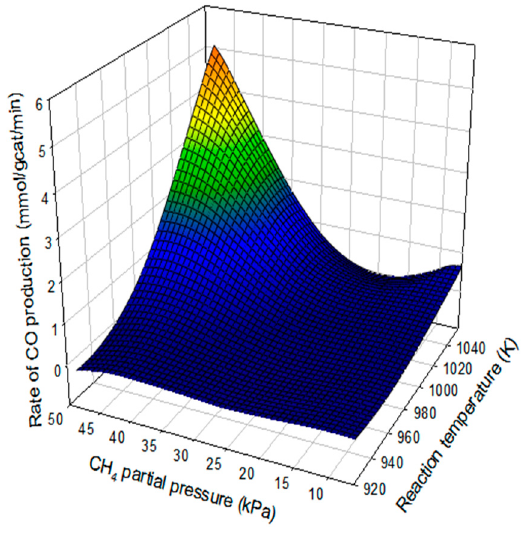
Figure 1. ( a ) Interaction effect of CH 4 partial pressure and reaction partial pressure on the rate of CO production; ( b ) Interaction effect of CO 2 partial pressure and reaction temperature on the rate of CO production; ( c ) Interaction effect of CH 4 partial pressure and CO 2 partial pressure on the rate of CO